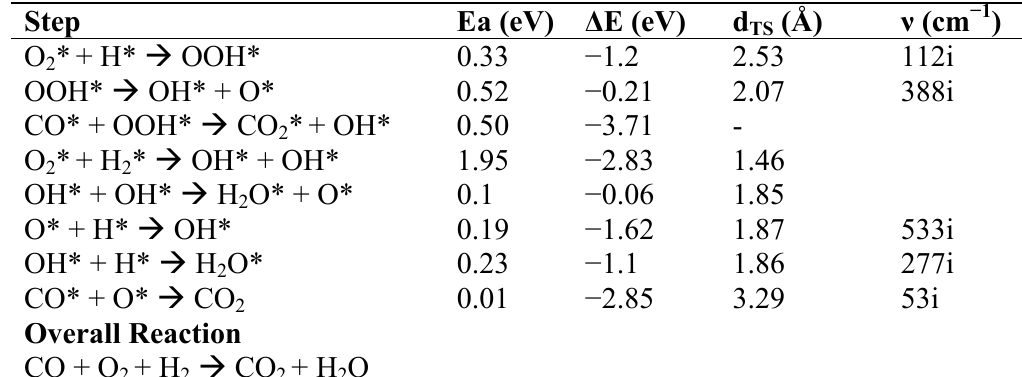
Table 3. Activation barrier, reaction energy and bond length and imaginary frequency in TS on Au(310)-p(2 ×